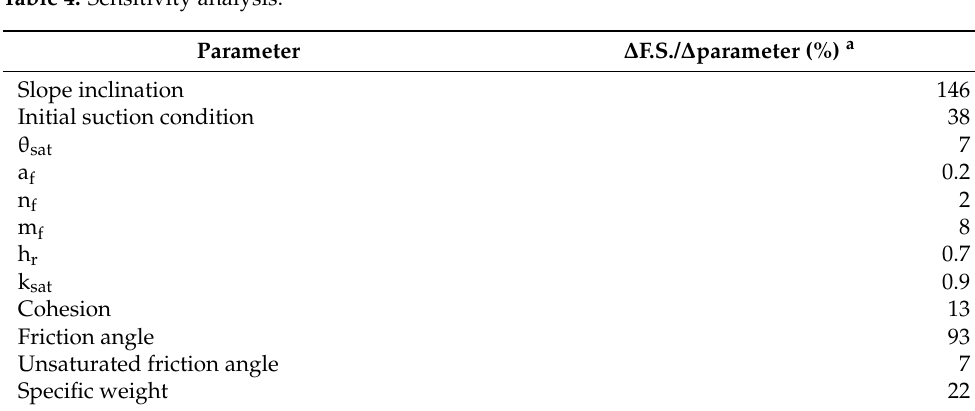
Table 4. Sensitivity